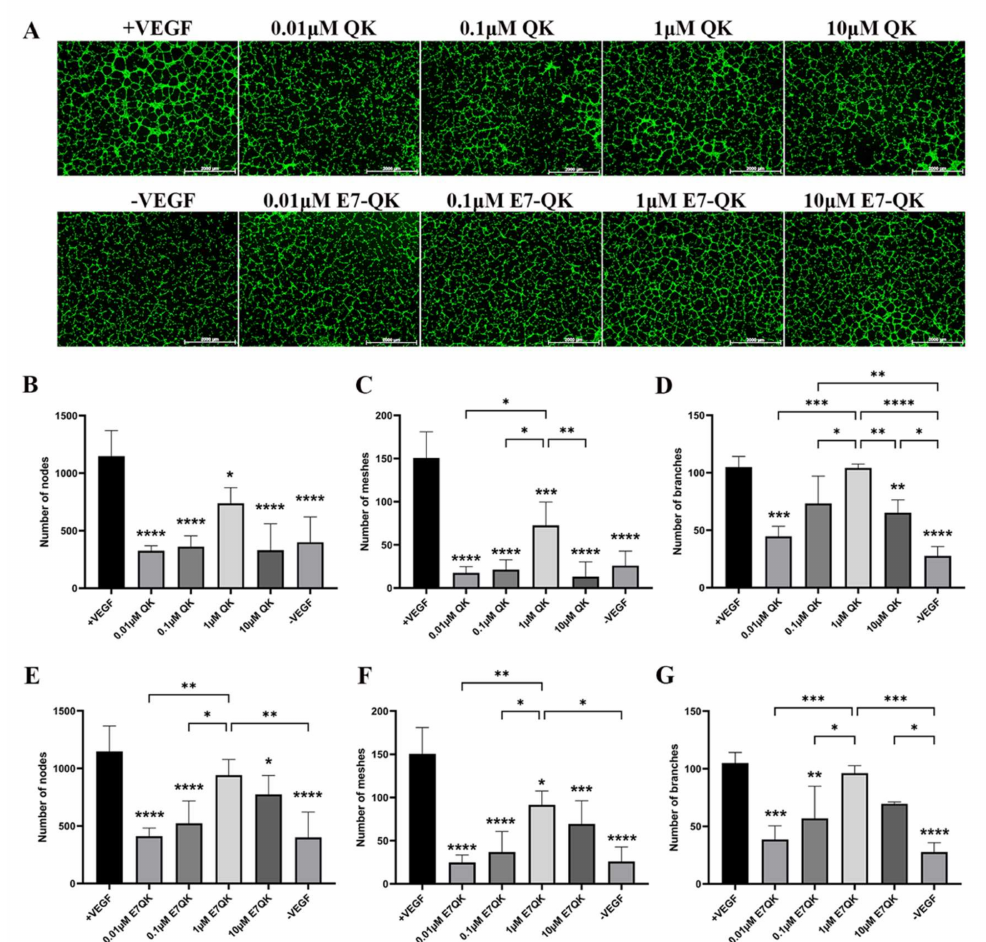
Figure 2. Tube formation of HUVECs incubated with different concentrations of VEGF and VEGF mimicry peptides (QK and E7-QK). HUVECs seeded on Geltrex matrix in medium containing dif- ferent concentrations of QK or E7-QK peptide (0.01 µ M, 0.1 µ M, 1 µ M, 10 µ M), VEGF (0.5 ng/mL, positive control group), or without VEGF or peptides (negative control group). ( A ) Representative images (1.25 × magnification, scale bar = 2000 µ m) of tube formation were taken using fluorescent mi- croscopy (Calcein AM) at 8 h after cell seeding. ( B , E ) Number of nodes, ( C , F ) number of meshes, and ( D , G ) number of branches were quantified with the ImageJ software. Values represent means ± SD from 3 independent experiments (*, **, ***, **** without bar indicates significant differences to the +VEGF group; * p < 0.05, ** p < 0.01, *** p < 0.001, **** p <